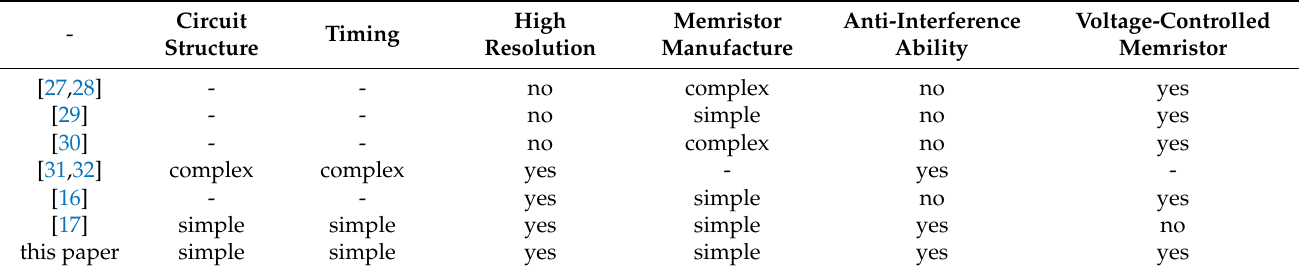
Table 4. The comparisons of the A/D